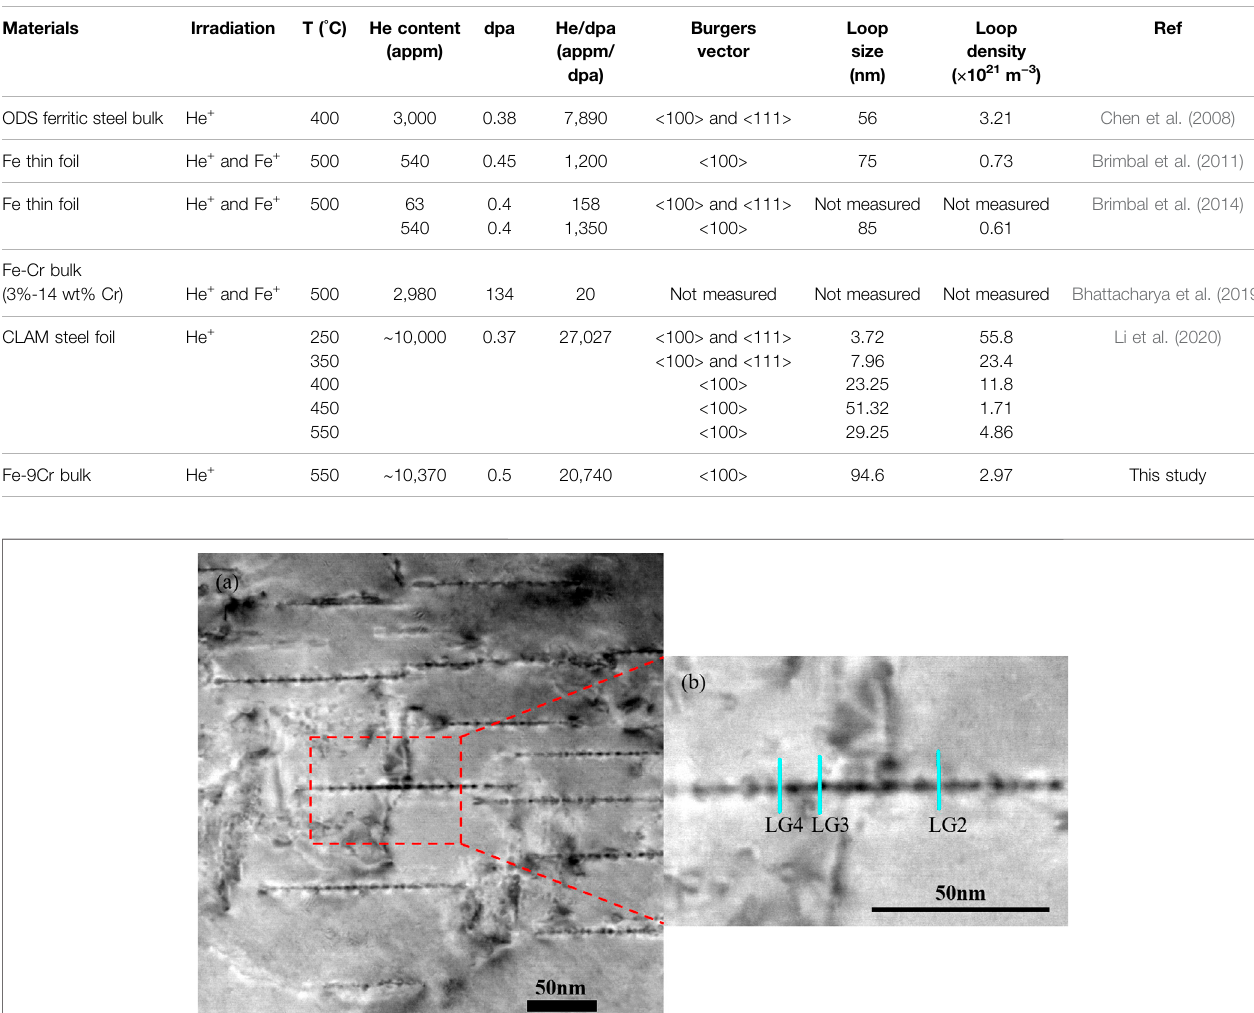
TABLE 4 | Summary of experimental studies on bubble-loop complexes in bcc Fe (Cr) alloys and F/M steels. T: irradiation temperature. Materials